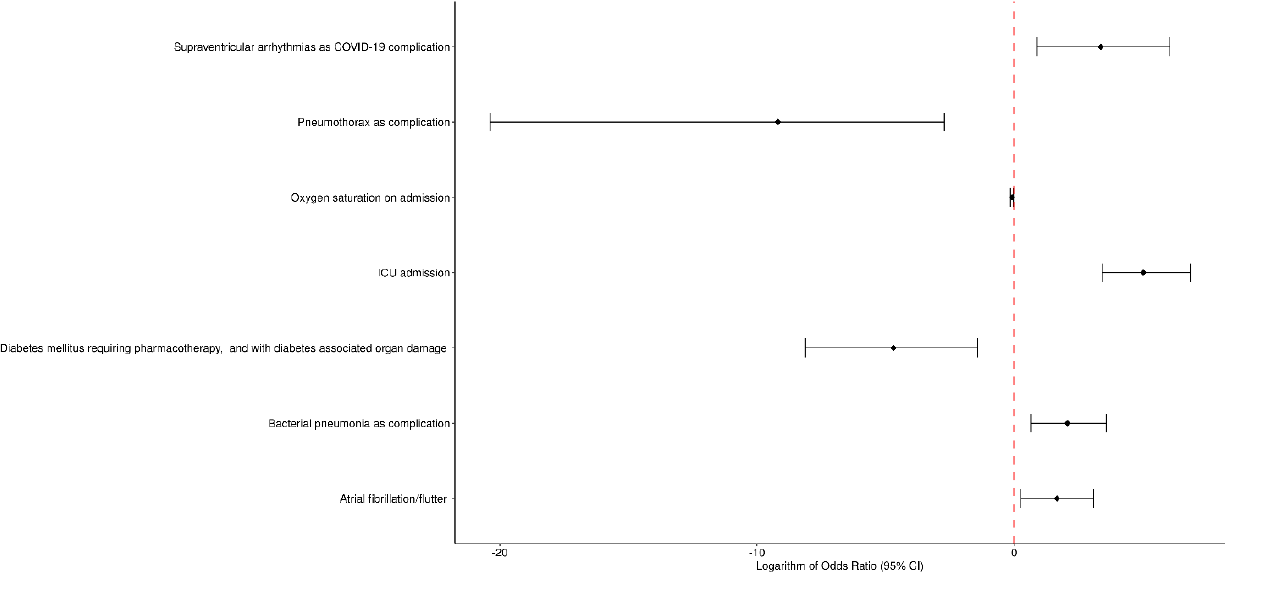
Figure 3. Multivariate logistic regression model analysis of the factors independently associated with death during the second COVID-19 wave in the Hospital for Infectious Diseases in Warsaw (Poland).